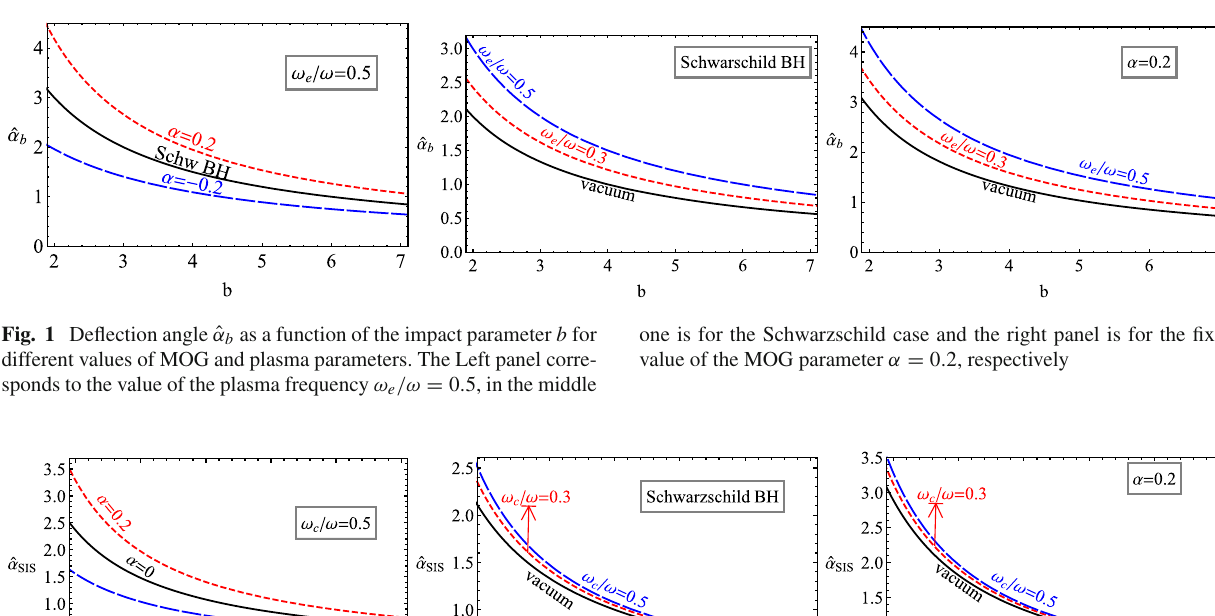
responds to the Schwrazschild case and right panel corresponds to the fixed values of the MOG parameter α = 0 .